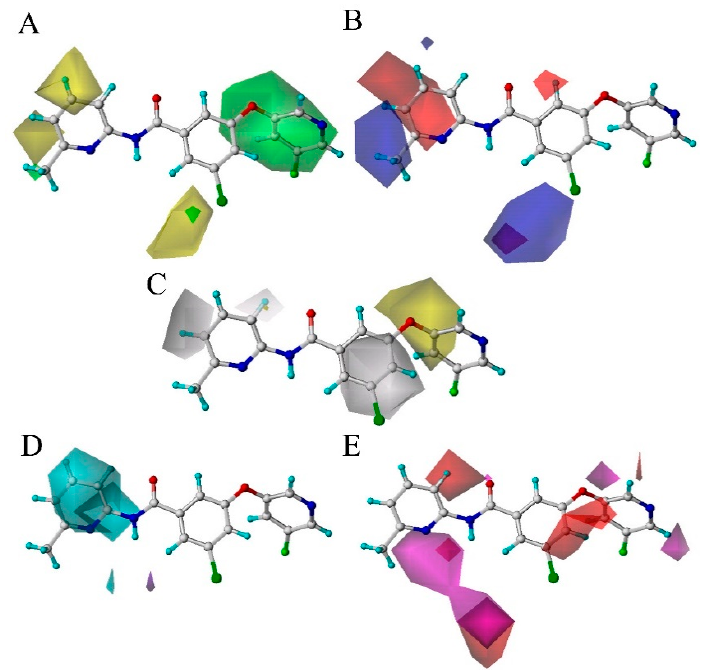
Figure 2. CoMSIA StDev*-Coe ff contour map. ( A ) Steric contour map: the green contours represent regions where bulky groups increase the activity, the yellow contours represent regions where bulky groups decrease the activity; ( B ) electrostatic contour map: the blue contours indicate regions where electropositive features promote the activity, the red contours indicate regions where electronegative features promote the activity; ( C ) hydrophobic contour map: the white contours indicate regions where hydrophobic groups are detrimental for the activity, the yellow contours indicate regions where hydrophobic groups are beneficial for the activity; ( D ) H-bond donor contour map: the cyan contours represent regions where H-bond donors promote the activity, the purple contours represent regions where H-bond donors demote the activity; ( E ) H-bond acceptor contour map: the purple contours represent the regions where H-bond acceptors are beneficial for the activity, while the red contours represent the regions where H-bond acceptors are detrimental to the